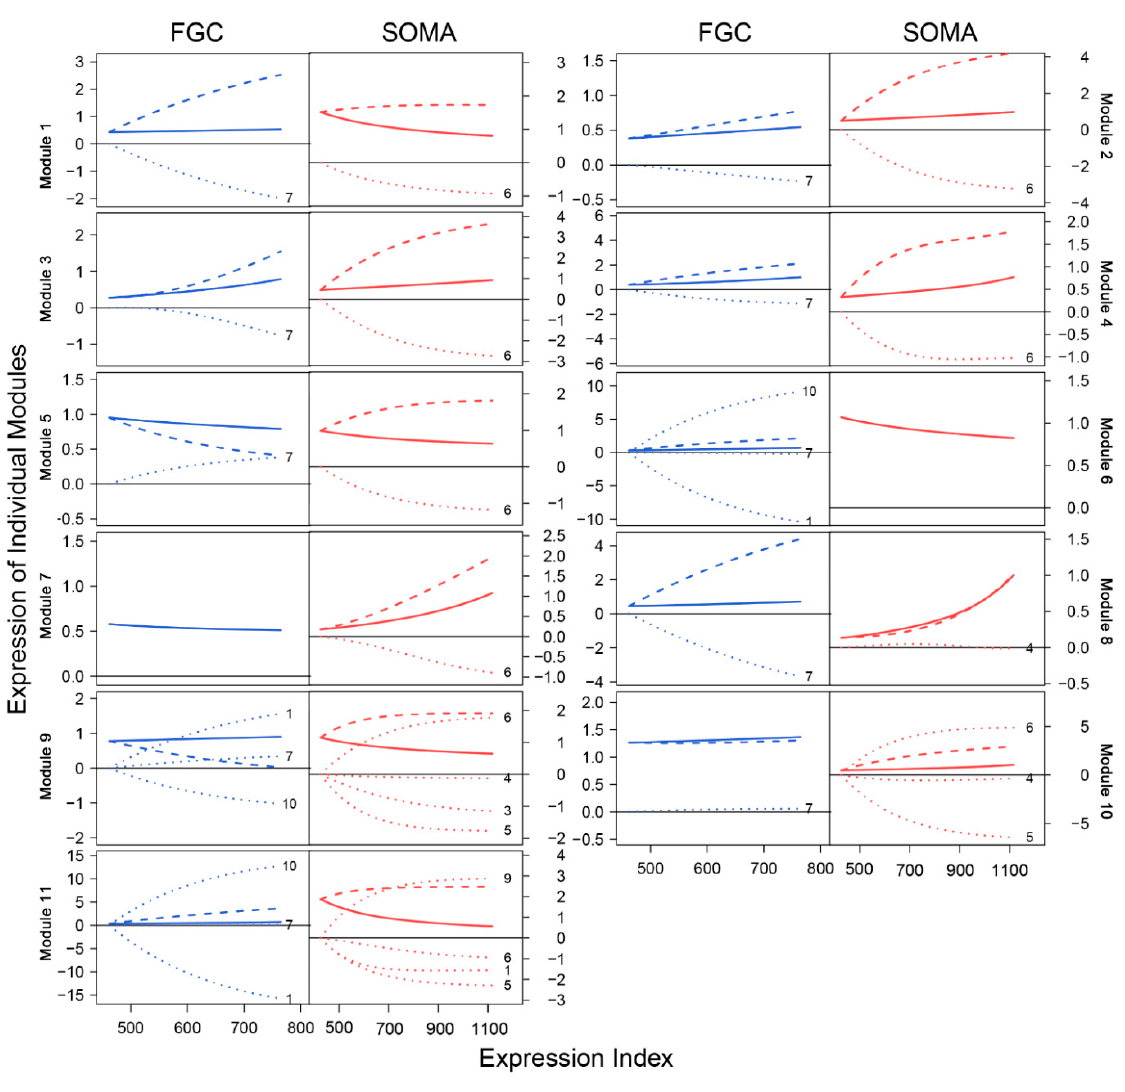
Figure 6. EI-varying changes of the overall gene expression of each module (solid line) and its independent (slash line) and dependent expression components (dot line) for FGCs (blue) and somas (red).